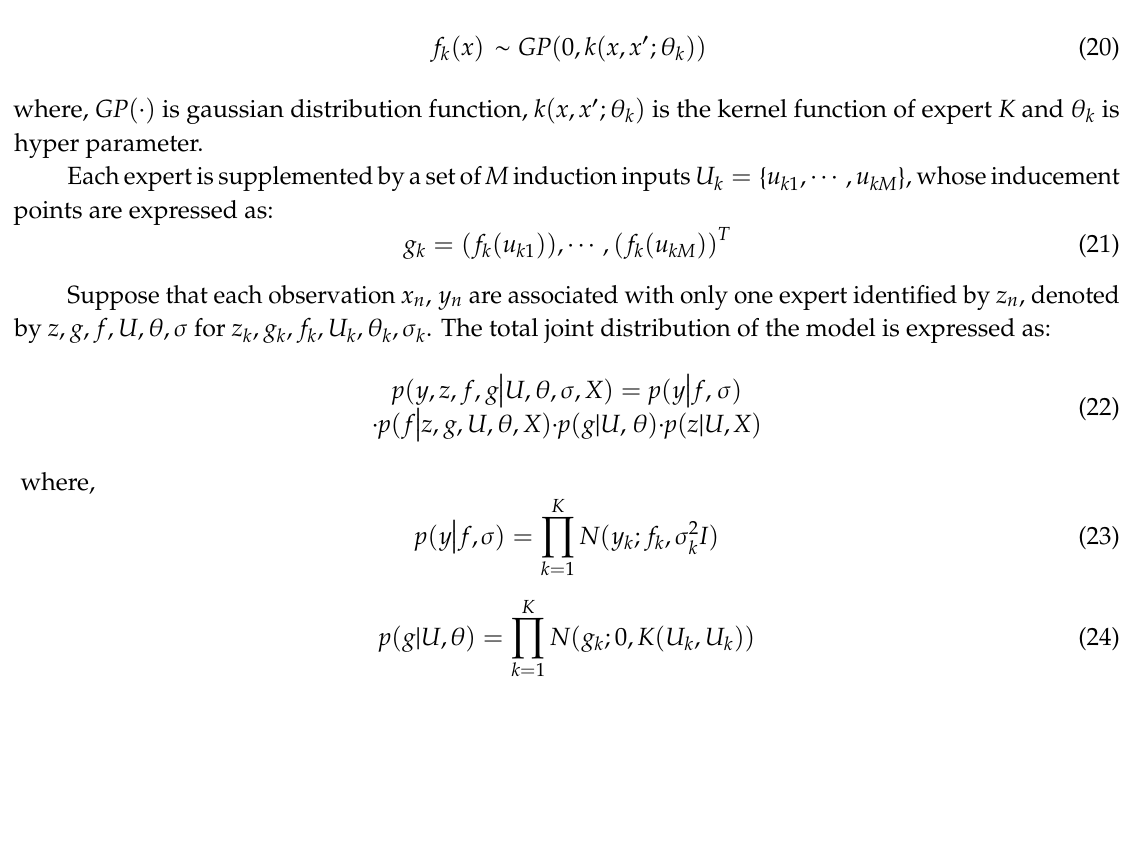
Figure 5. Mixture Gaussian process regression (MGPR) model representation.